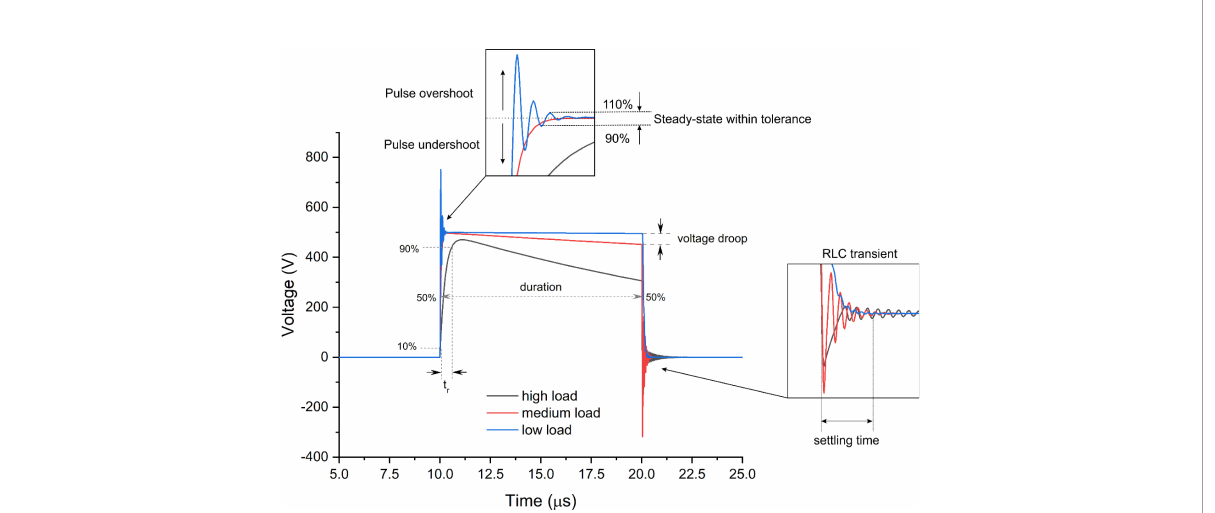
FIGURE 2 An example of typical transient processes occurrent in electroporation systems during pulse delivery, where t r is the pulse rise time and RLC is the resistor/inductor/capacitor